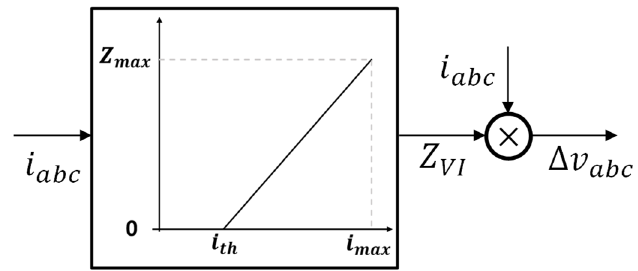
Figure 4. Transient virtual impedance loop.